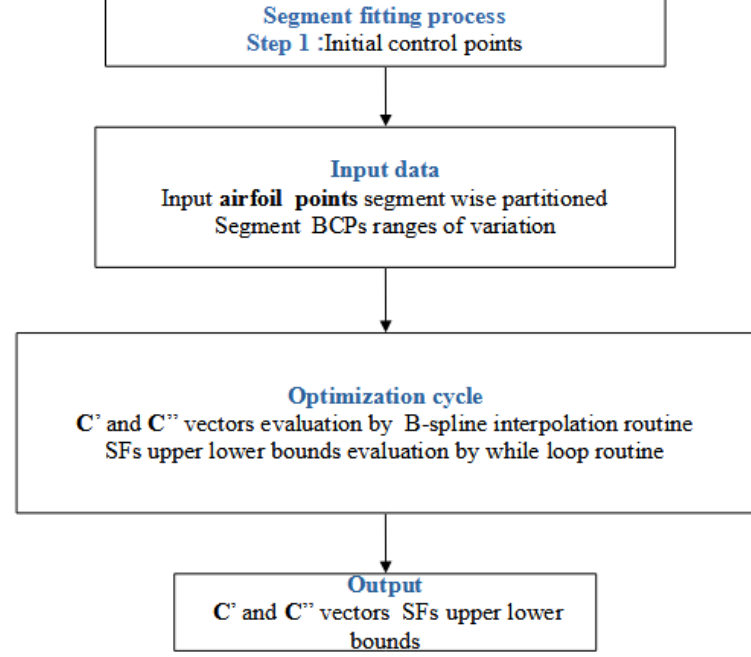
Figure 11. Segment fitting process, step1 flowchart.